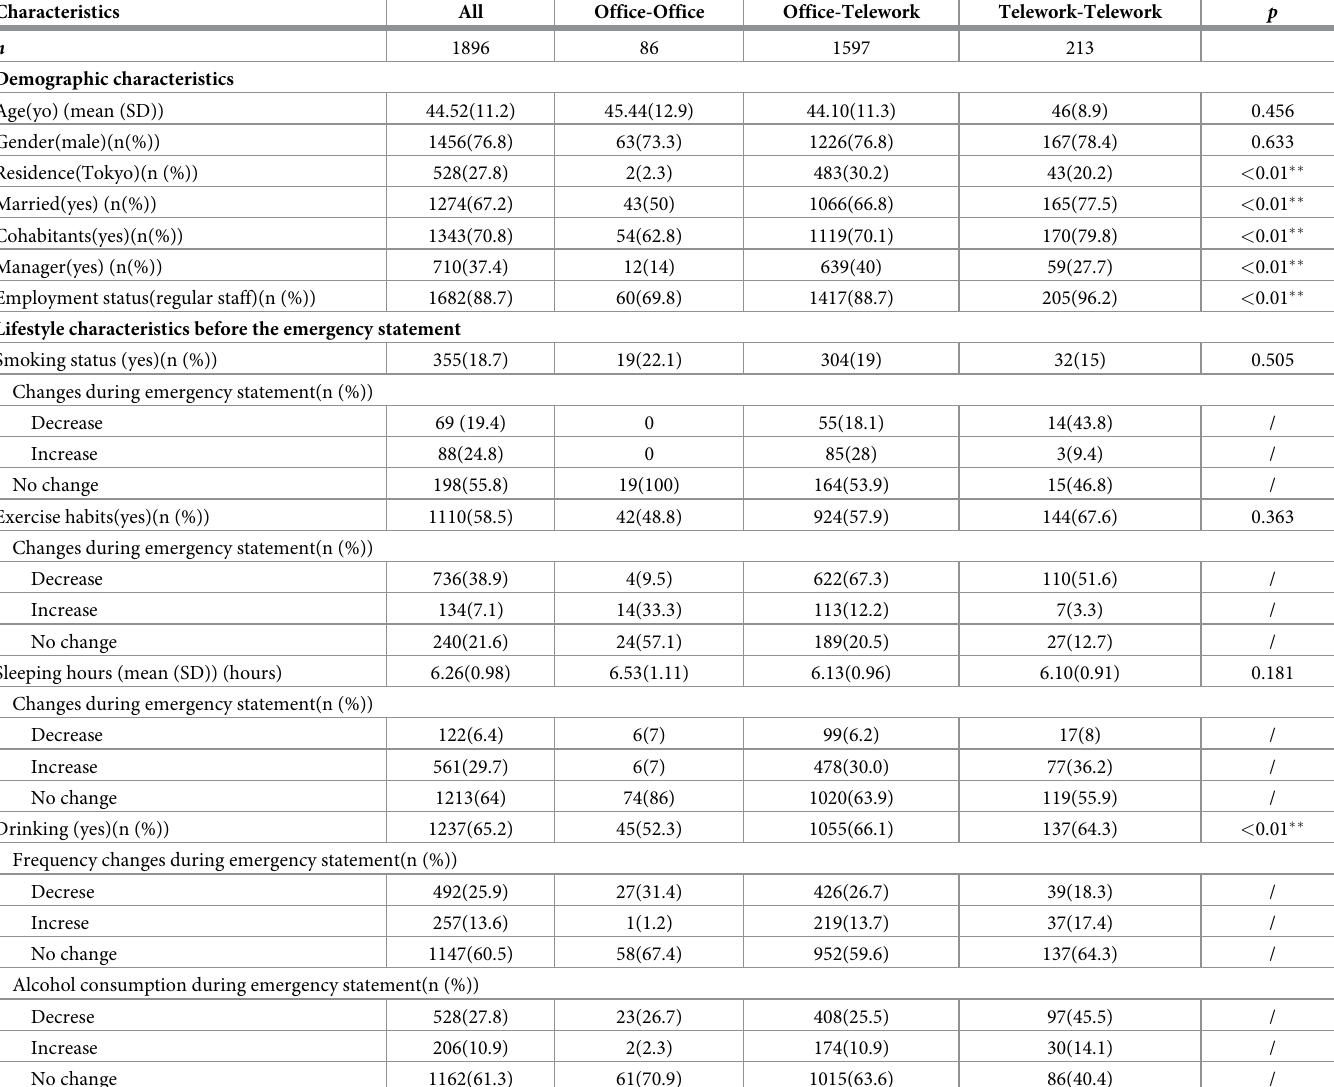
Table 1. Recruitment and demographic, lifestyle changes during emergency statement by telework or not 1 .